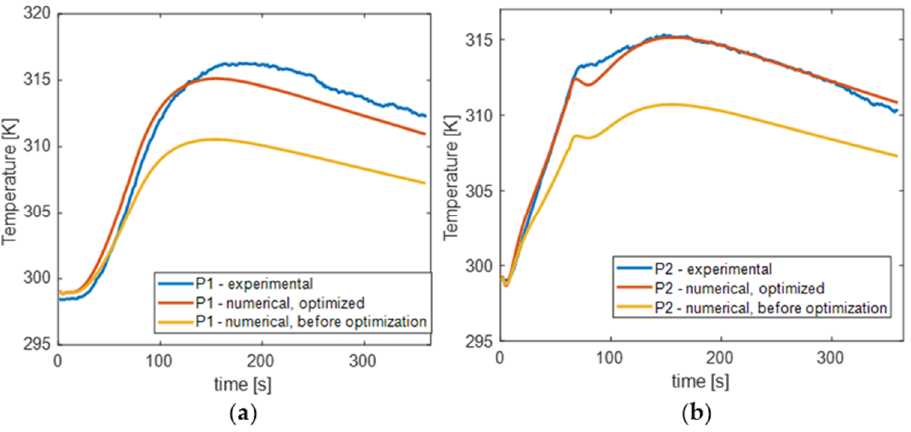
Figure 8. Averaged time–temperature characteristics from regions P1 and P2 compared with numerical data. ( a ) Comparison of the experimental (blue line) characteristic for the region P1 and numerical result: yellow line—before optimization, red line—after. ( b ) Analogical comparison for region P2.